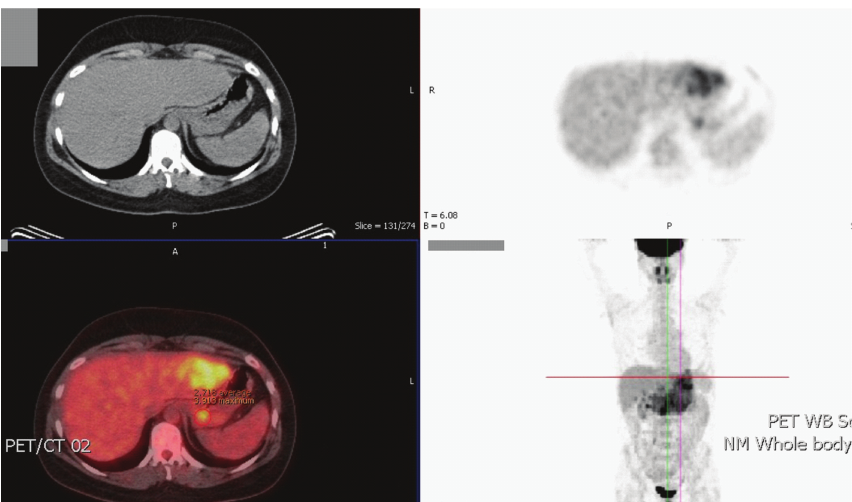
Figure 3: PET CT showing areas of increased 18 FDG uptake correlating to lesions in segments two, three, and 4 of the